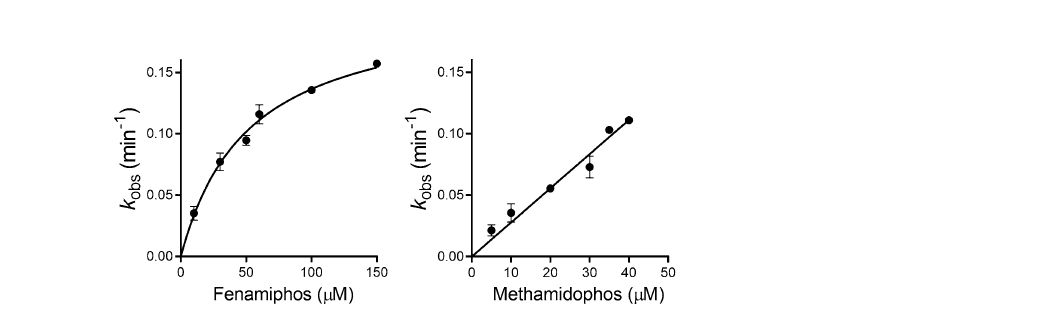
Figure 2. Progressive inhibition of recombinant human AChE with fenamiphos and methamidophos determined at 25 °C. Values are expressed as mean ± SEM (n =